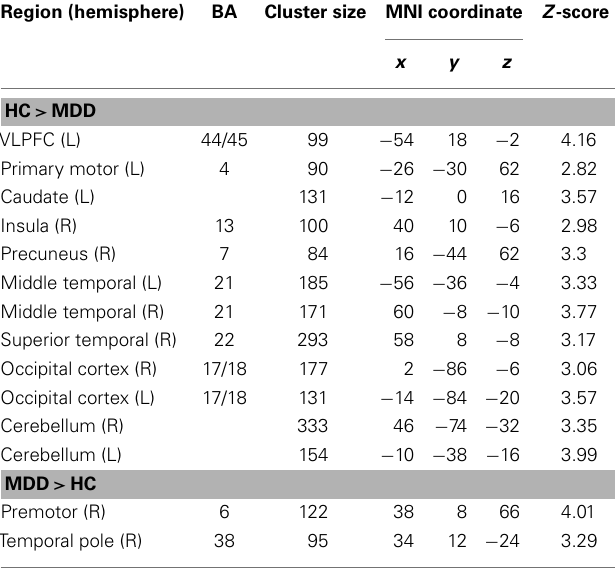
Table 2 | Brain regions exhibiting a significant difference between patients with MDD and HC in the resting-state functional connectivity with the left amygdala ( p < 0.05, corrected for multiple